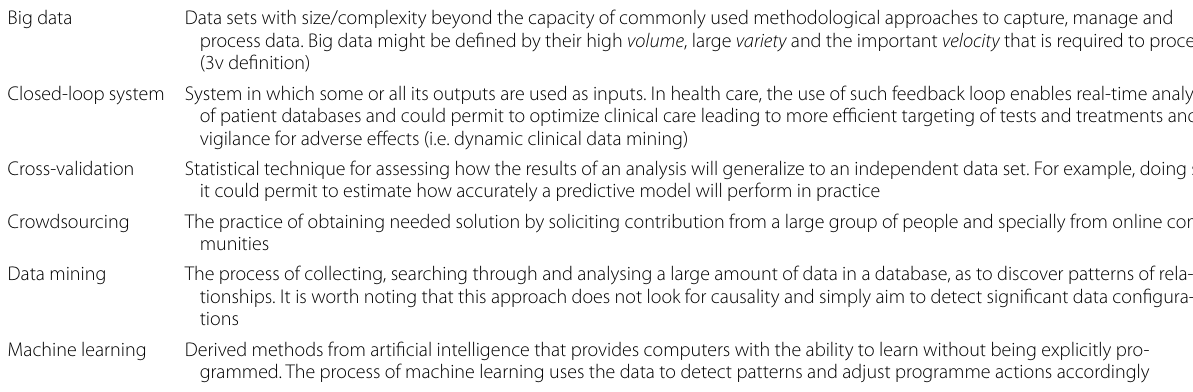
Table 1 Data-driven analysis and related terminology Big data